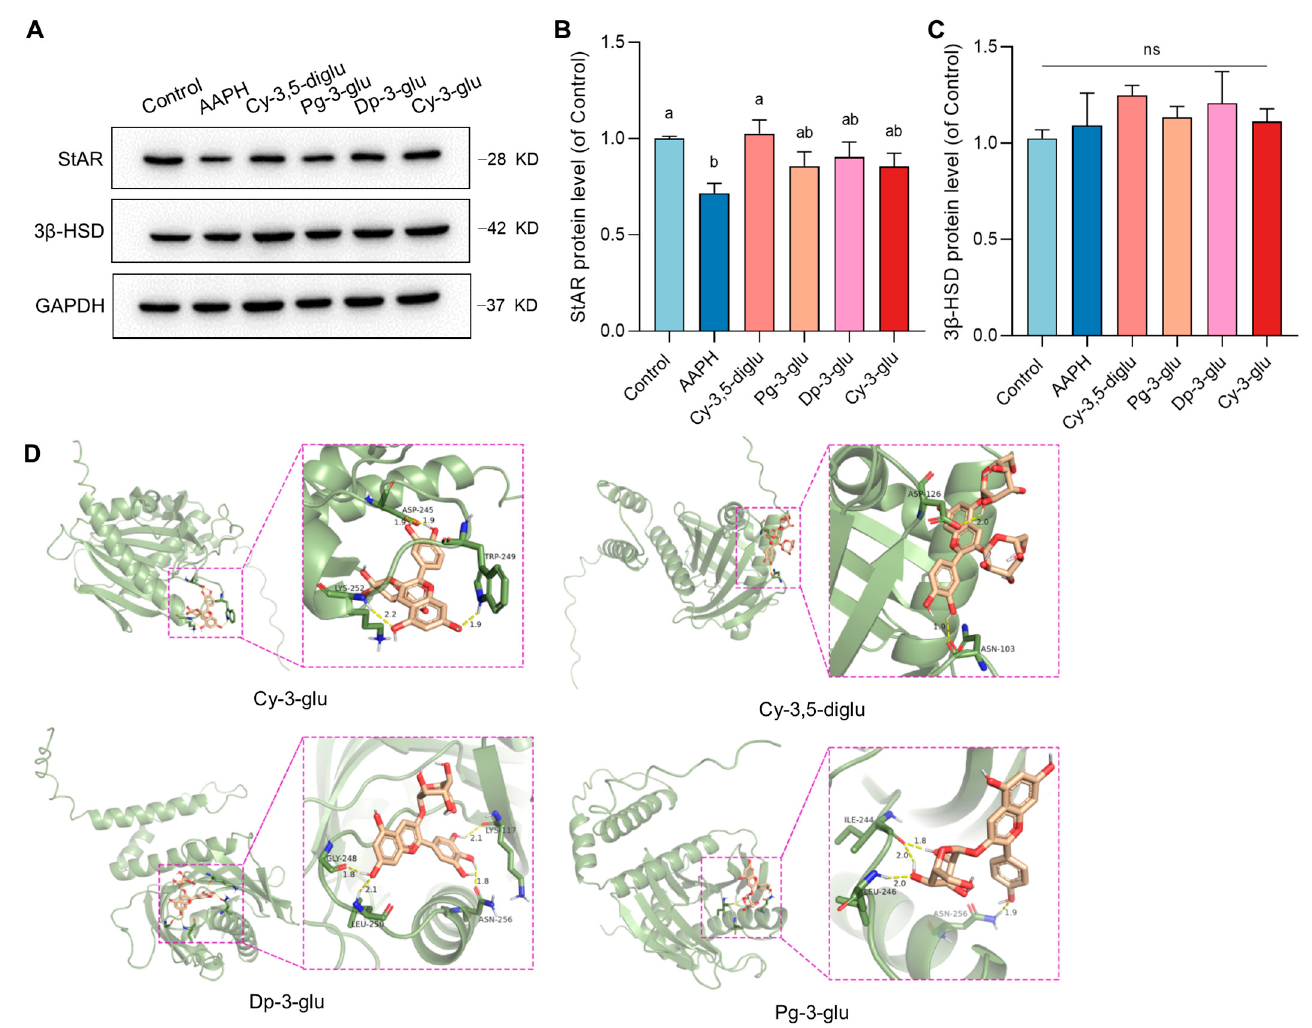
Figure 6. Anthocyanins target the protein involved in progesterone synthesis: ( A ) The representative photographs of Western blot band of StAR and 3 β -HSD. ( B ) The grayscale analysis of StAR, n = 3. ( C ) The grayscale analysis of 3 β -HSD, n = 3. ( D ) Molecular docking of four anthocyanins and StAR. Different letters indicated that there is a significant difference ( p < 0.05). Table 1. Binding energy and sites between four anthocyanins and StAR based on molecular dock- ing.